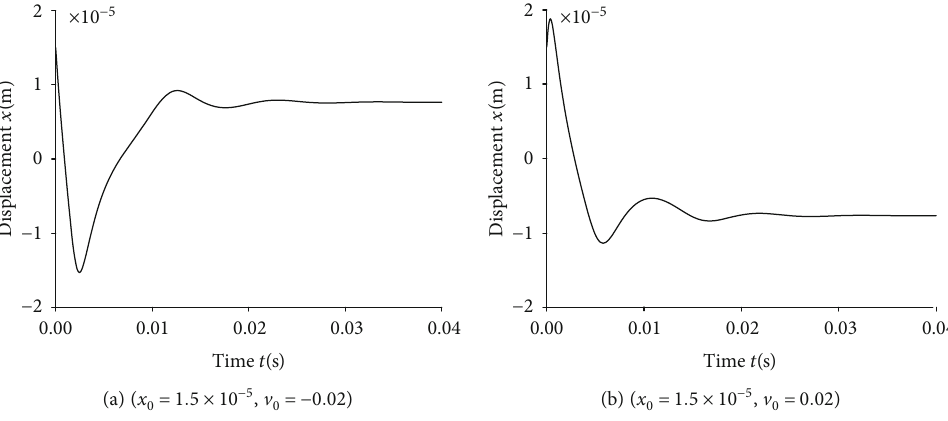
= 1 : 0A , q = 0 : 3 × 10 − 4 m 3 /s . 0 0